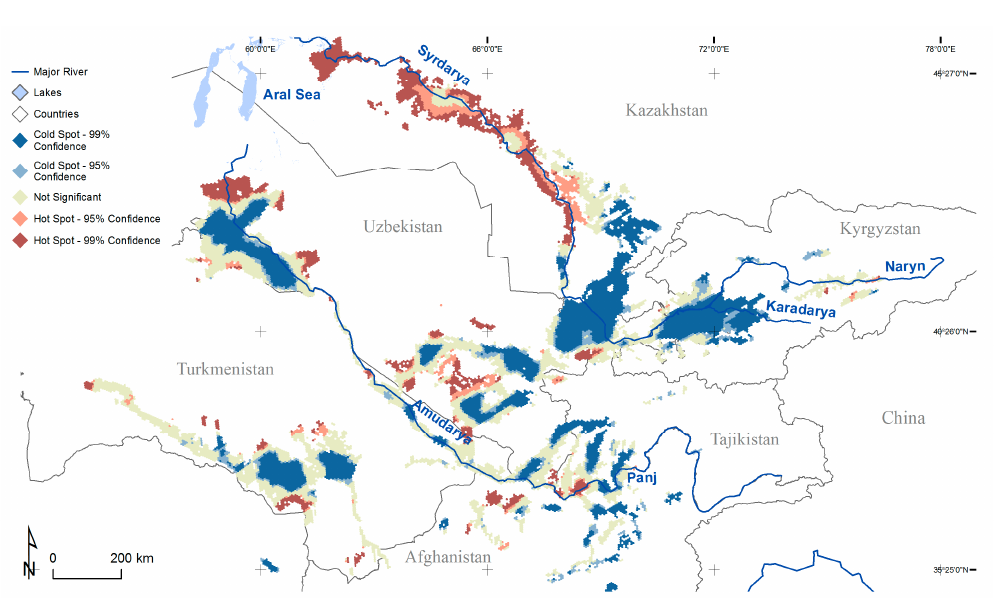
Figure 8. Hotspots of abandoned irrigated cropland (orange—95% of confidence and red color—99% of confidence) and active irrigated cropland (light blue—95% of confidence and dark blue color—99% of confidence) in the six countries of the Aral Sea Basin as derived by the stratified classifier method. For the correct interpretation of colors, please refer to the digital version of the manuscript.